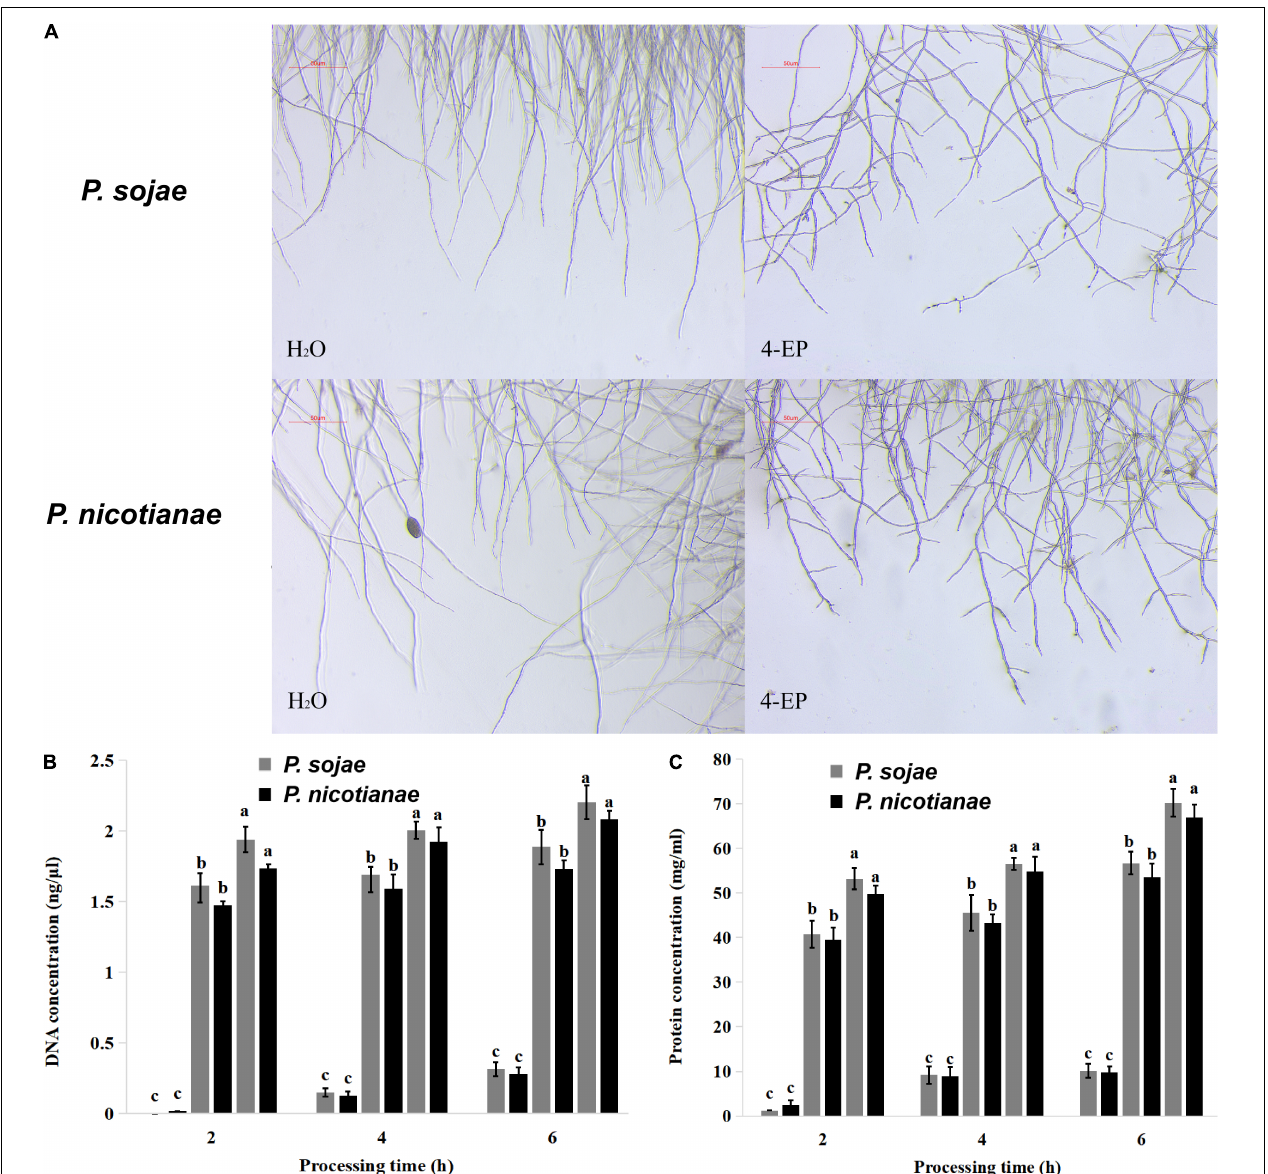
FIGURE 2 | Effect of 4-Ethylphenol on Phytophthora spp. morphology and DNA and protein leakage. (A) Effect of 4-Ethylphenol on the morphology of P . sojae and P. nicotianae treated with 4-Ethylphenol for 2 h; (B) effect of 4-Ethylphenol on DNA leakage of P. sojae and P. nicotianae ; (C) effect of 4-Ethylphenol on protein leakage of P. sojae and P. nicotianae